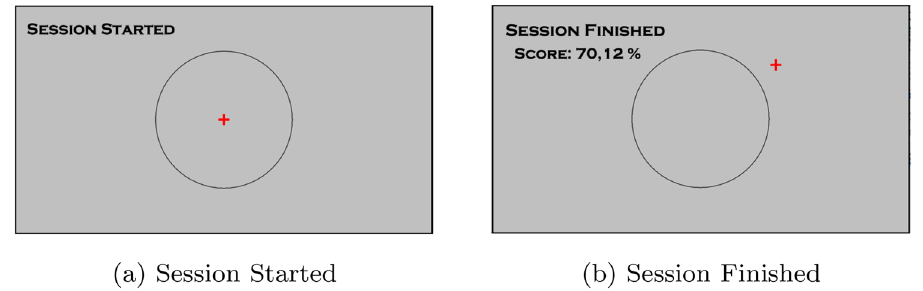
Figure 3. Screenshots from the CPT game. At the beginning of the game ( a ), the cross starts to run away from the center of the black circumference. The user goal is to bring the cross back to the center by using the mouse. At the end of each trial ( b ), the score indicates the percentage of time spent by the cross inside the